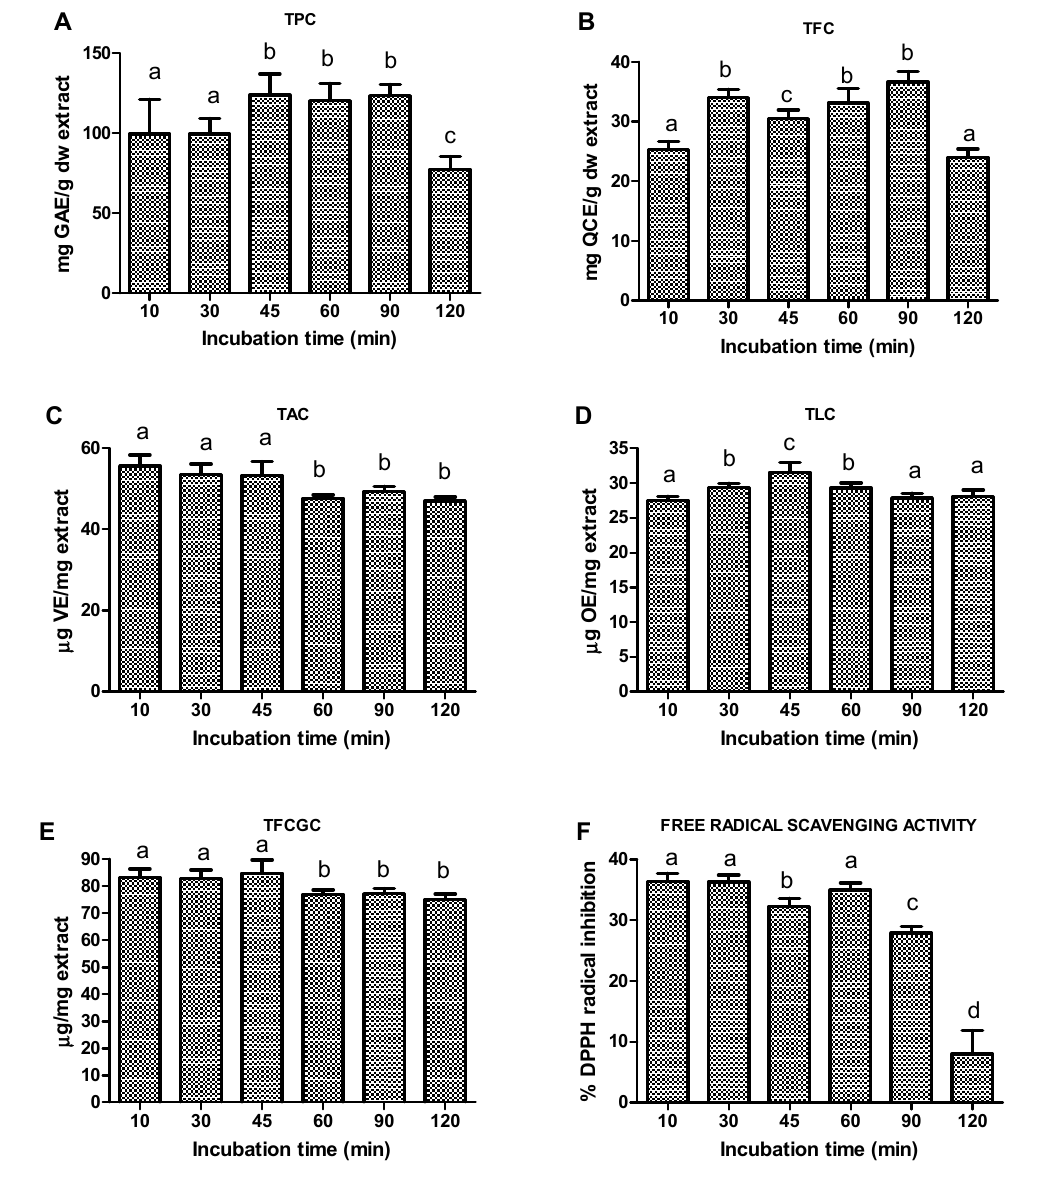
Figure 8. Effects of incubation time on the acid hydrolysis for TPC ( A ), TFC ( B ), TAC ( C ), TLC ( D ), TFCGC ( E ), and DPPH free radical scavenging activity ( F ) from OPLs. Different letters indicate significant difference between tested parameters ( p < 0.05). DW stands for dried weight.